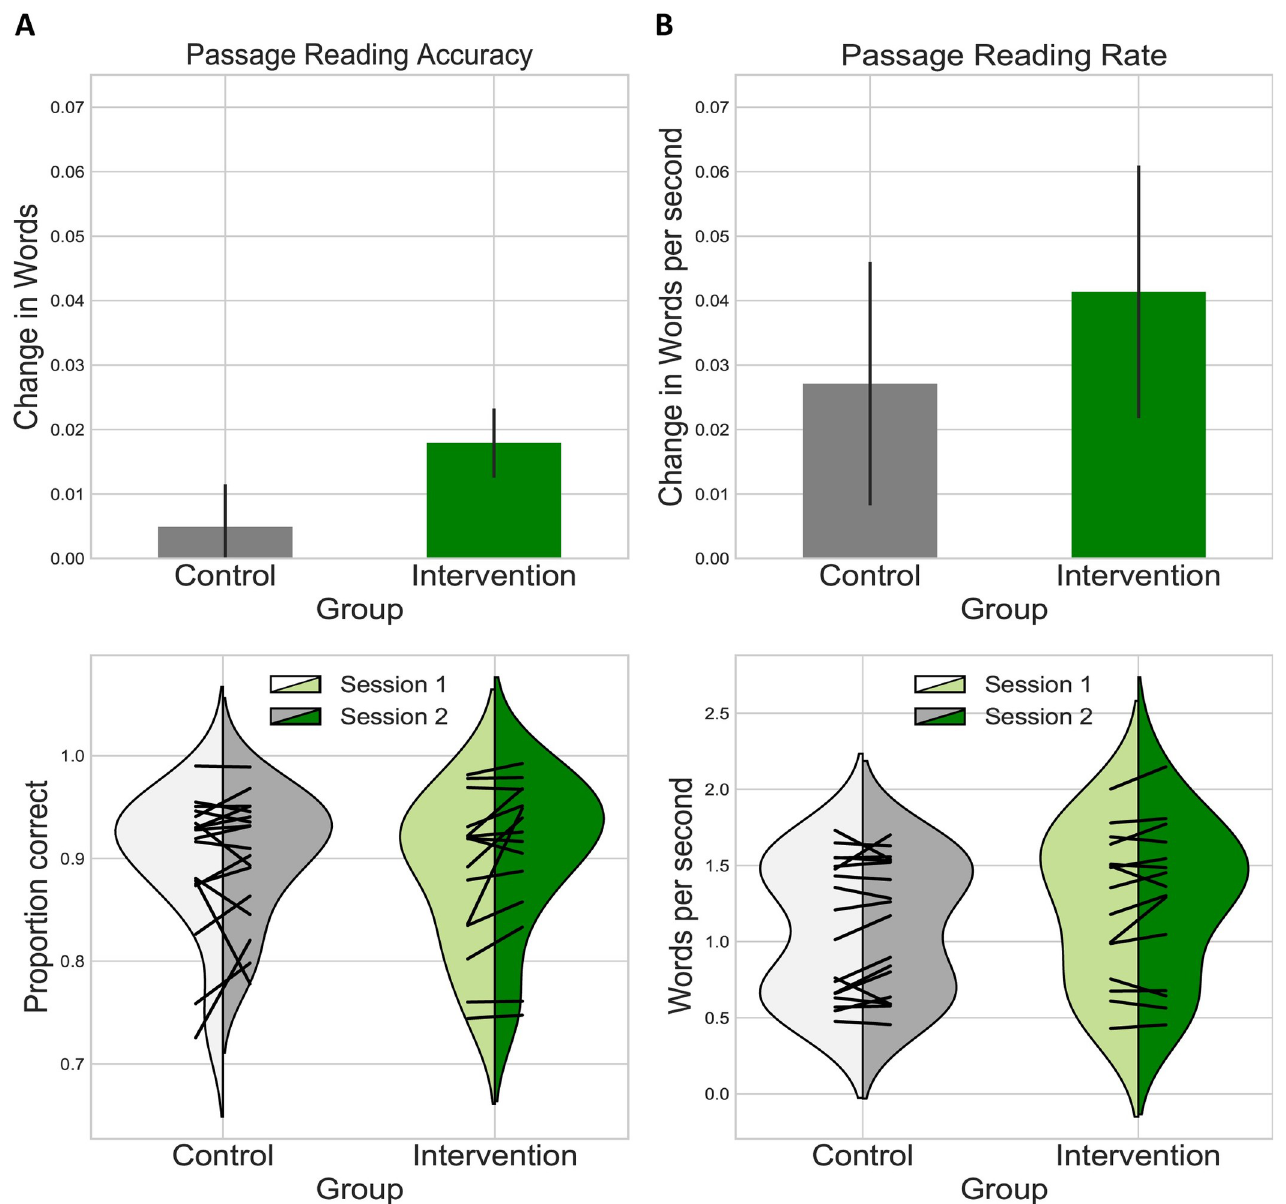
Fig 3. Accuracy and rate for connected text reading. Bar graphs depict difference scores from the first and second sessions for both the control and intervention groups for word reading accuracy (A) and rate (B). Bar heights represent the additional number of words read correctly and additional accurate words per second on the second session. Error bars reflect +/- 1 SEM. Below the bar plots, violin density plots show group performance on these measures for both sessions with superimposed line plots of individual performance.